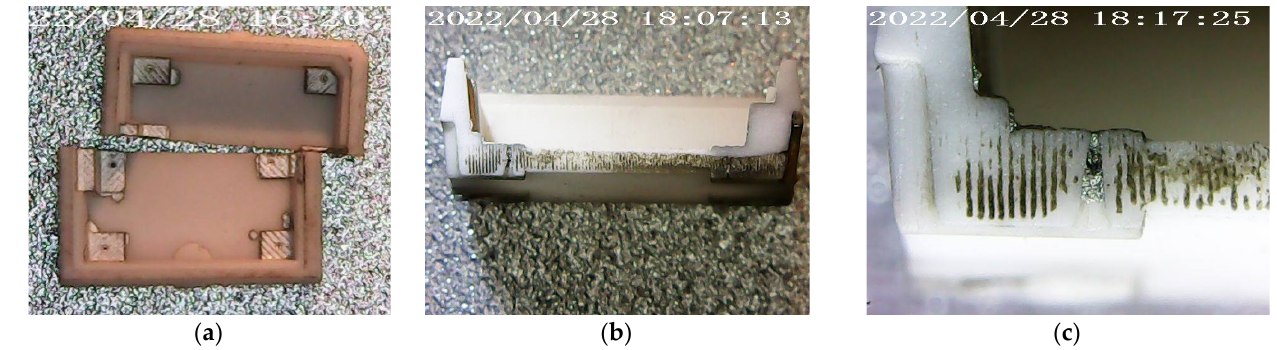
Figure 6. The results of laser cutting the bottom part of a metal–ceramic package on the via hole line: ( a ) the bottom part of a metal–ceramic package, cut into two parts by a laser; ( b ) cross-section of the bottom part of a metal–ceramic package; ( c ) the enlarged photo of a via not completely filled with silver ink.